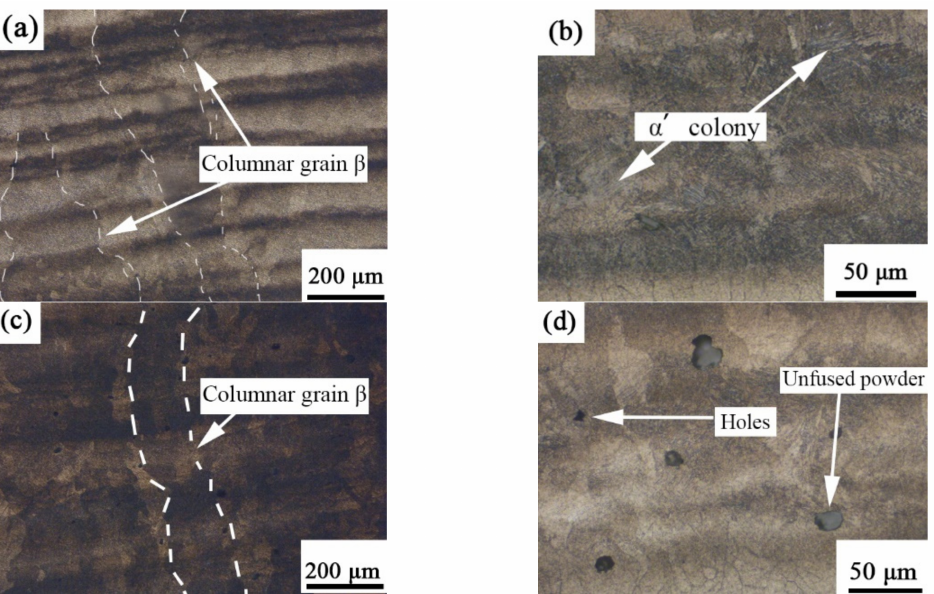
Figure 3. Metallographic diagram of longitudinal section (parallel to deposition direction) of SLM- formed samples: ( a , b ) TC11 titanium alloy; ( c , d ) GNPs/TC11